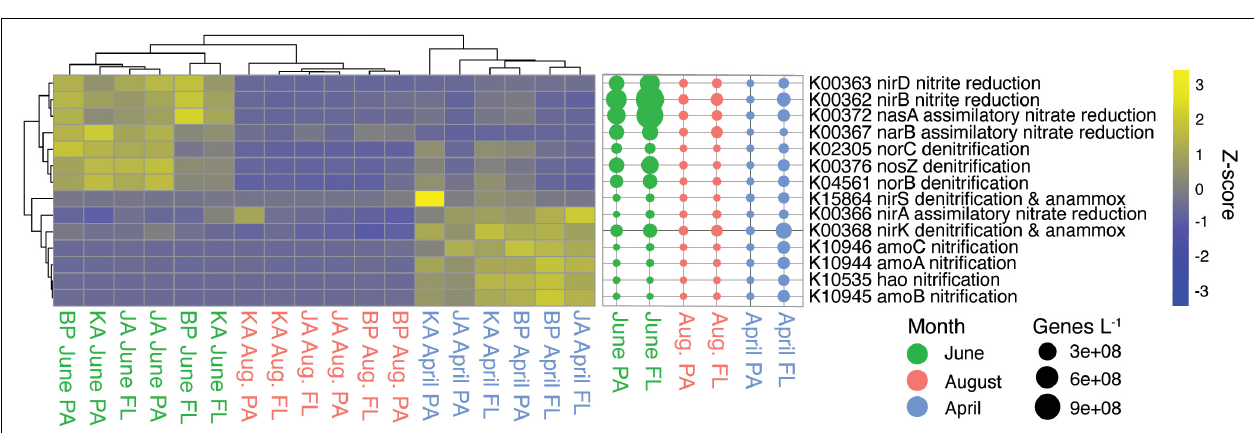
FIGURE 5 | Nitrogen cycle indicator genes (KEGG pathway map00910). Heatmap of z-scaled GPM gene abundances for each sample with yellow being higher abundance and blue lower. Bubble plot of genes/L abundance for each month and size-fraction